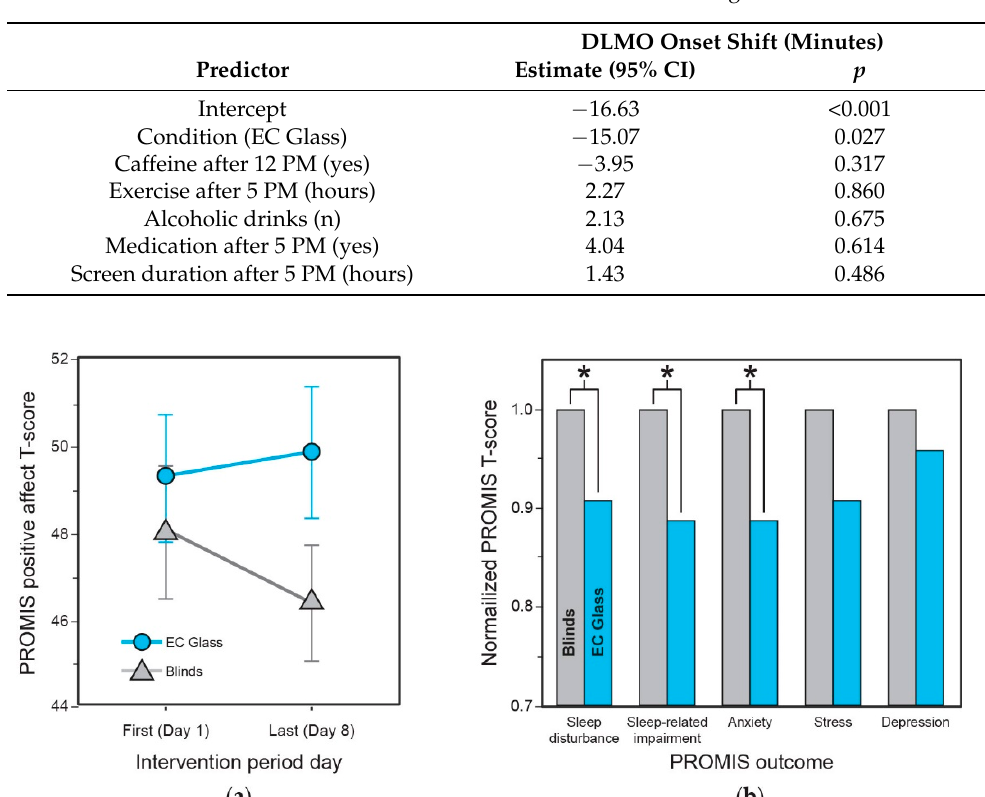
Figure 7. ( a ) PROMIS Positive Affect I5a instrument score (T-score) over the course of the week (start = Day 1 to end = Day 8) in the EC Glass versus Blinds conditions. ( b ) Normalized results of the linear mixed effects model comparing the PROMIS statement subscore (scale of 1–5) across interventions for sleep disturbance ( p = 0.036), sleep-related impairment ( p = 0.049), anxiety ( p = 0.023), stress ( p = 0.075), and depression ( p = 0.30). Lower normalized PROMIS T-scores represent improved values in these outcomes. p -values indicate results of the within-subjects linear mixed effects model, x-axis describes scale statements assessed for each PROMIS instrument. (Statistical significance: * represents p ≤ 0.05).